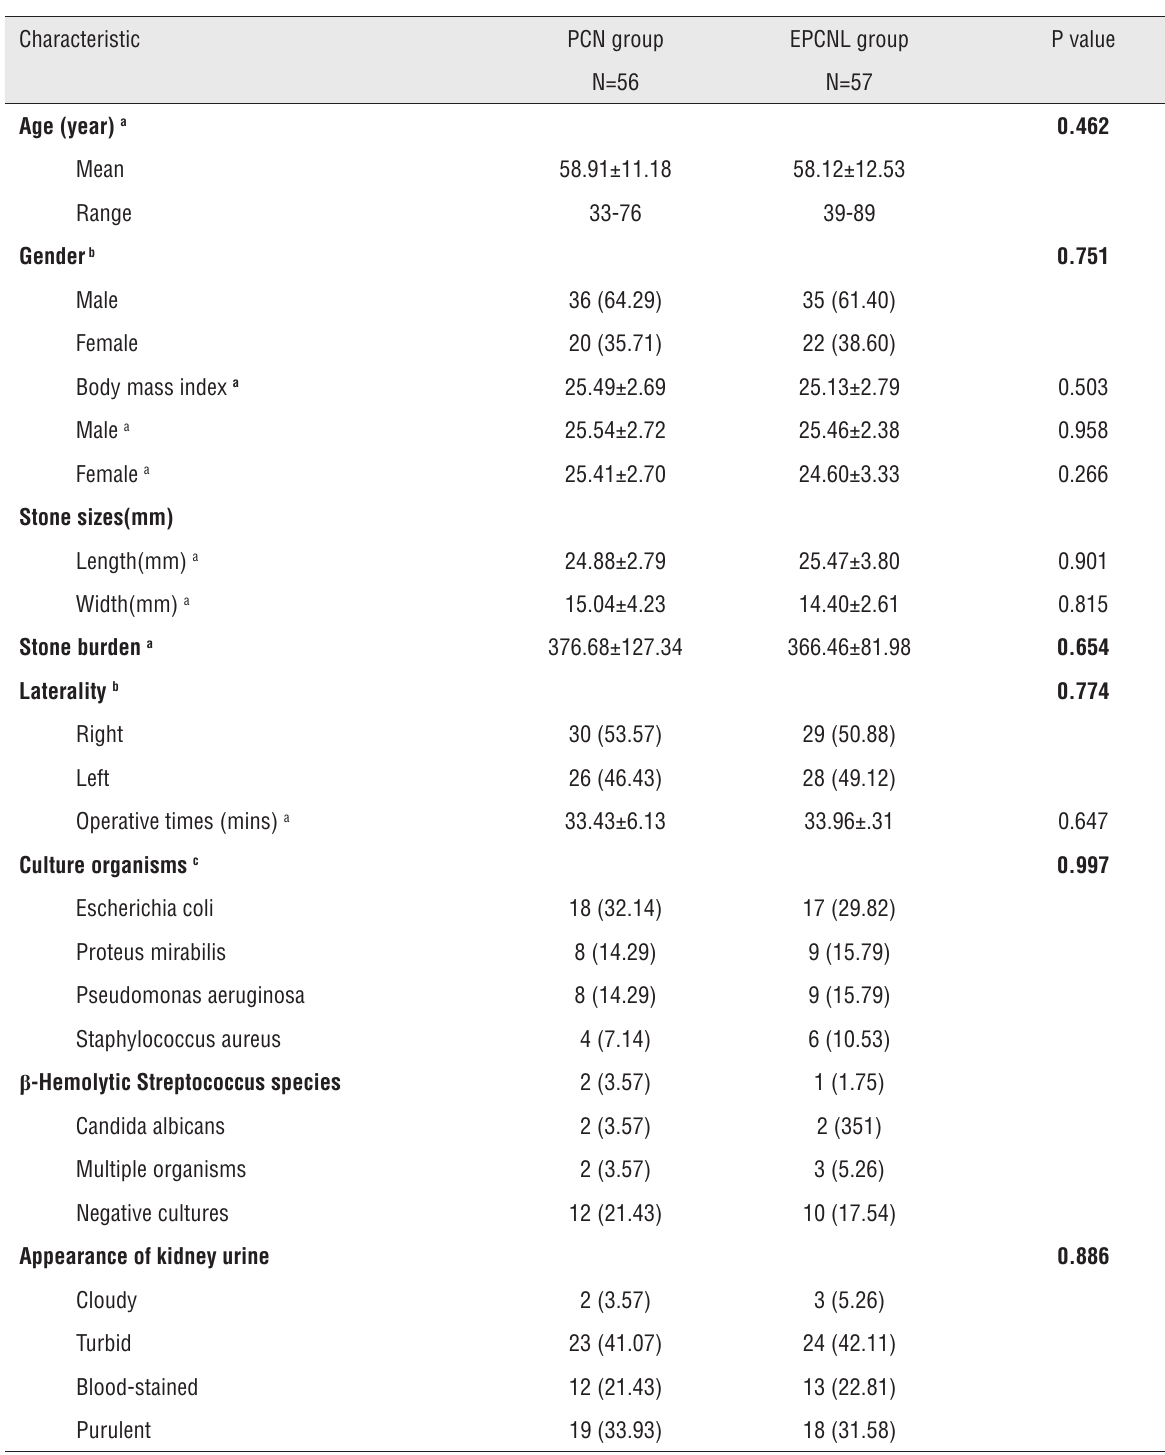
Table 1 - Patients Demographics and Perioperative